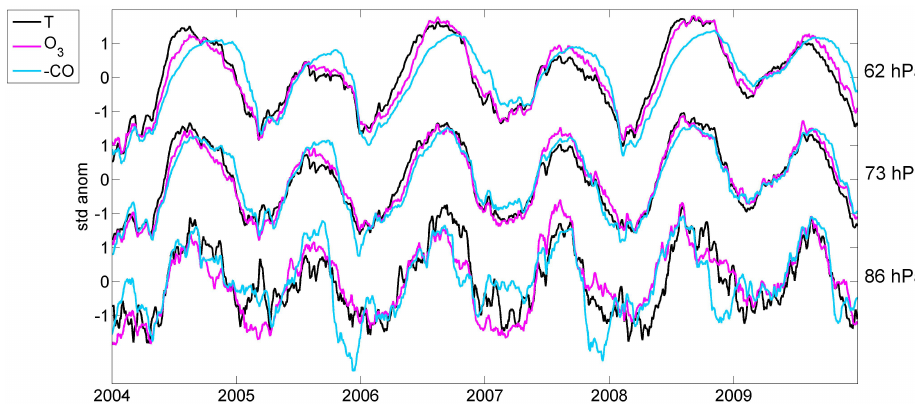
Fig. 3. Time series of zonal mean temperature, ozone and CO from WACCM at 62, 73 and 86hPa averaged over 18 ◦ S–18 ◦ N. Standardized anomalies are shown for each level, and the anomalies of CO are inverted to highlight correlated behavior.